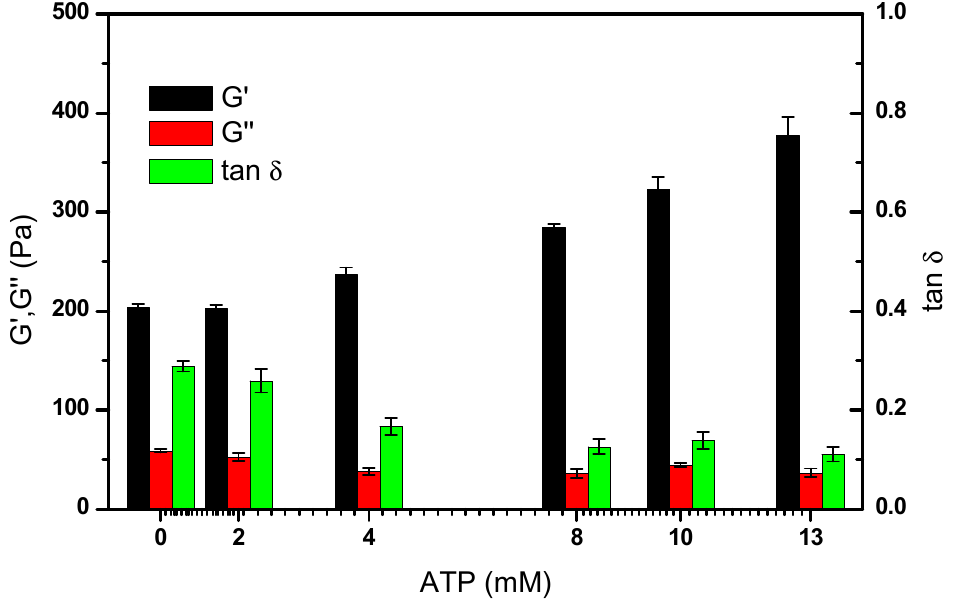
Figure 3. Variation tendency of the mechanical properties of DNA hydrogels, i.e., storage modulus (G’), loss modulus (G’’), and loss tangent (tan δ ), under an ATP concentration gradient from 0 to 12.5 mM. All the measurements were carried out three times to get the average and statistical analysis was applied to get the error bar.